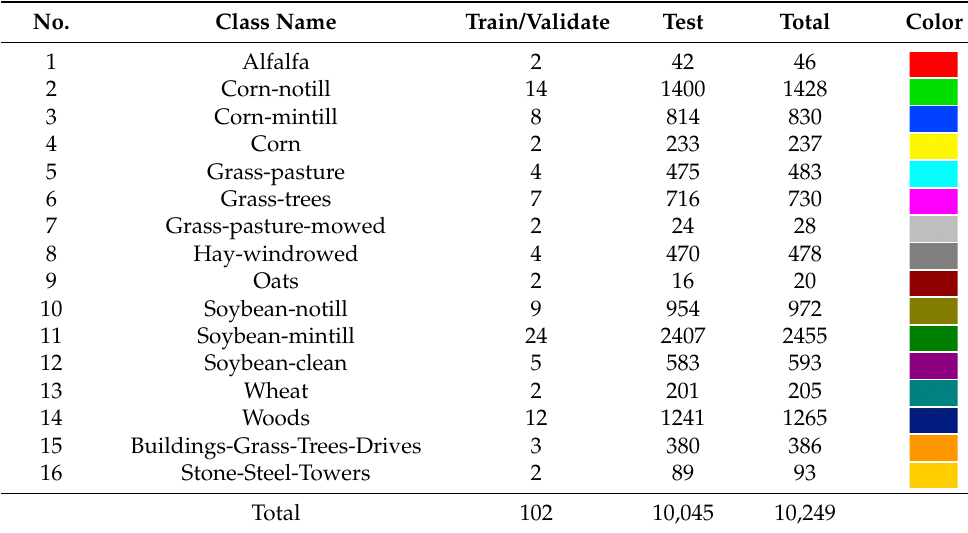
Table 1. The training and testing sample numbers and colors of the IP dataset.